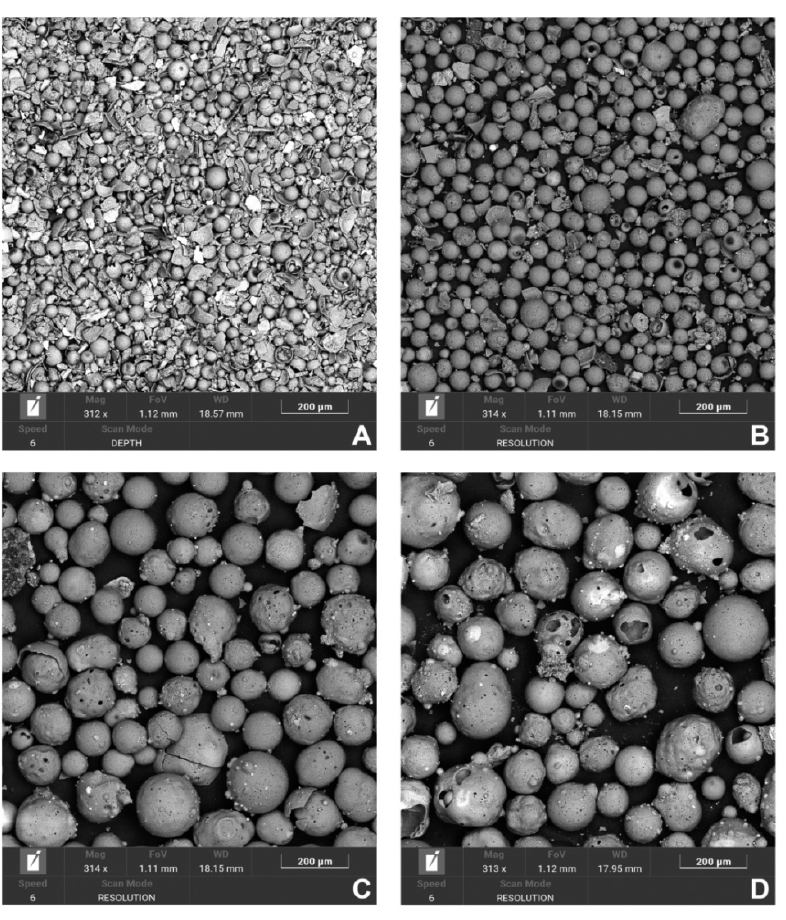
Figure 3. The obtained, purified cenospheres’ fractions (energy: 20 keV), mag. 300 × : ( A ) F_45, ( B ) F_90, ( C ) F_150, and ( D ) F_212.